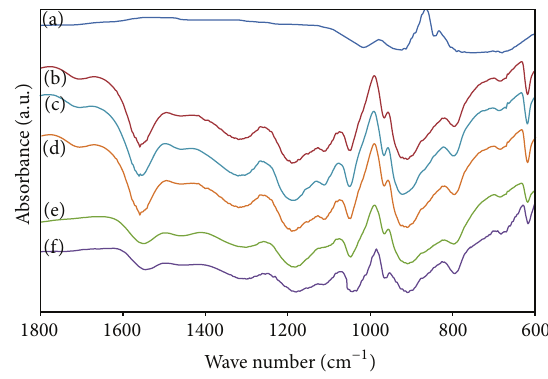
Figure 1: FT-IR spectra of WO 3 -Ppy PNCs with particle loadings of (a) pure WO 3 , (b) 5, (c) 10, (d) 15, (e) 20 wt%, and (f) pure Ppy,